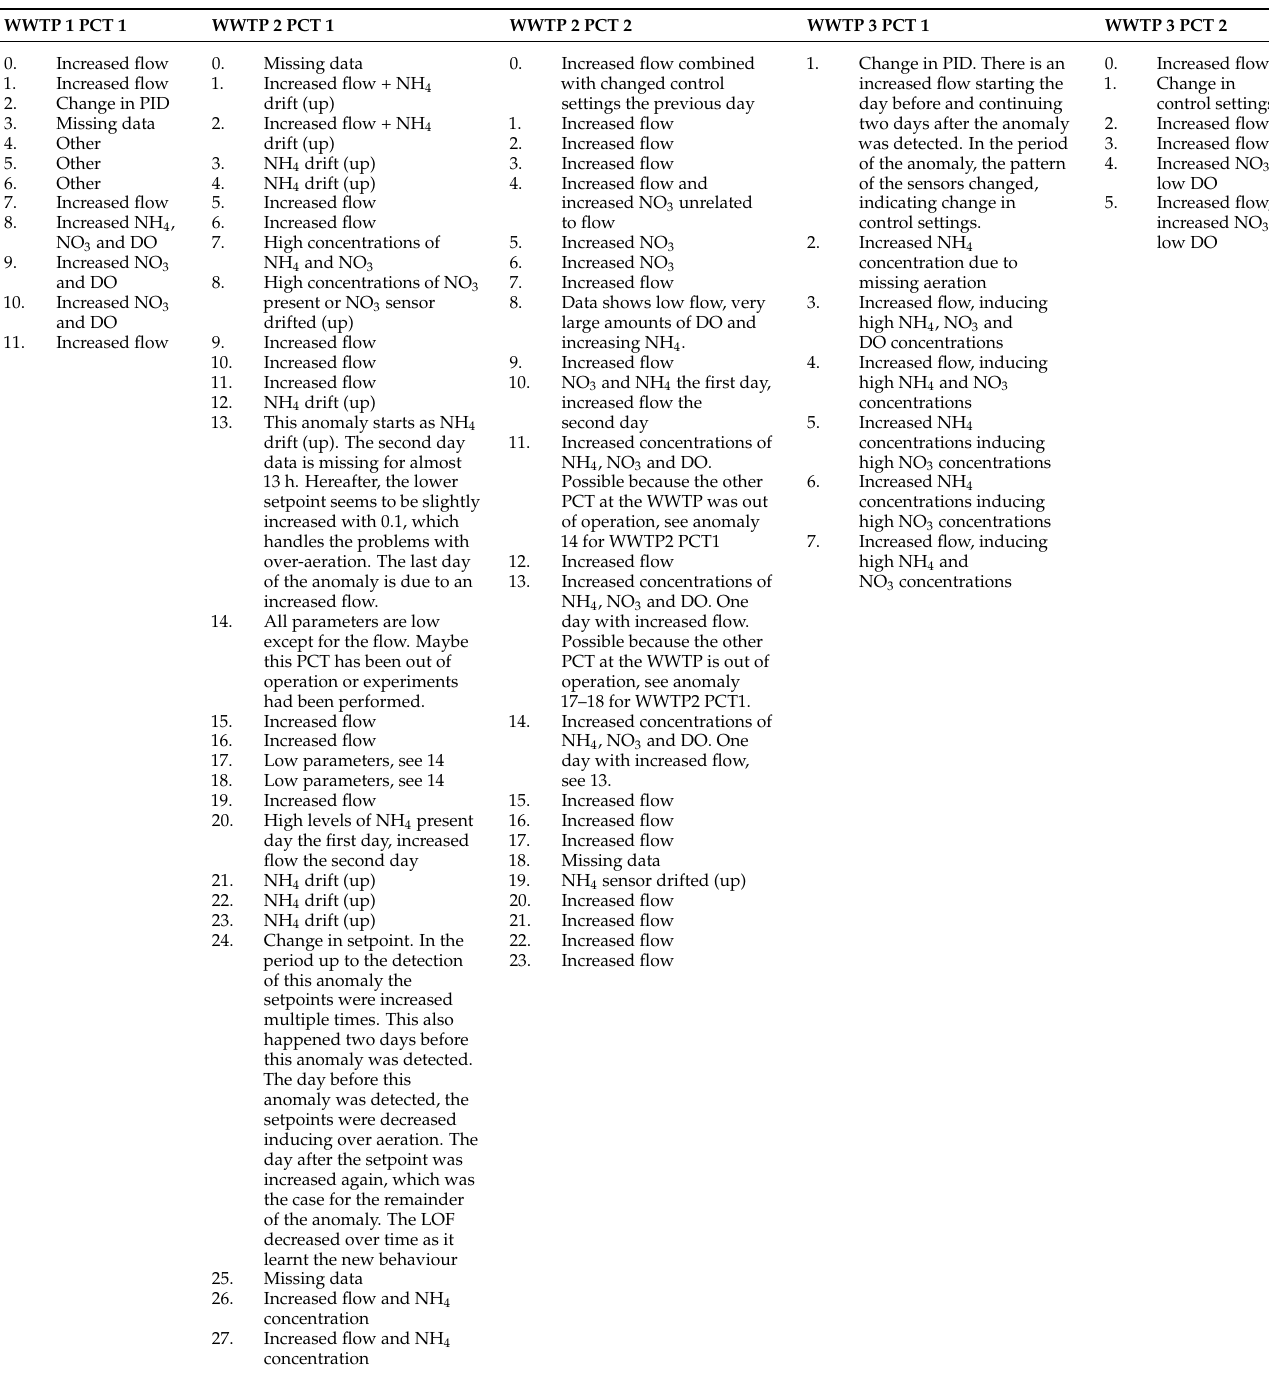
Table 2. Overview of the anomalies detected in the five PCTs when using Moving LOF and a threshold of